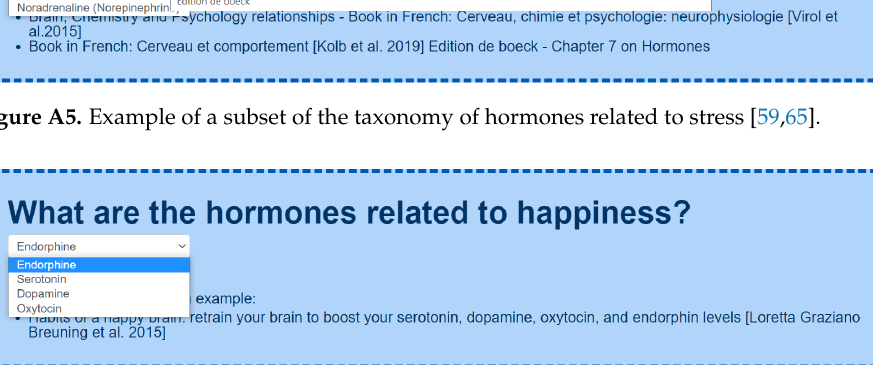
Figure A6. Example of a subset of the taxonomy of hormones related to happiness